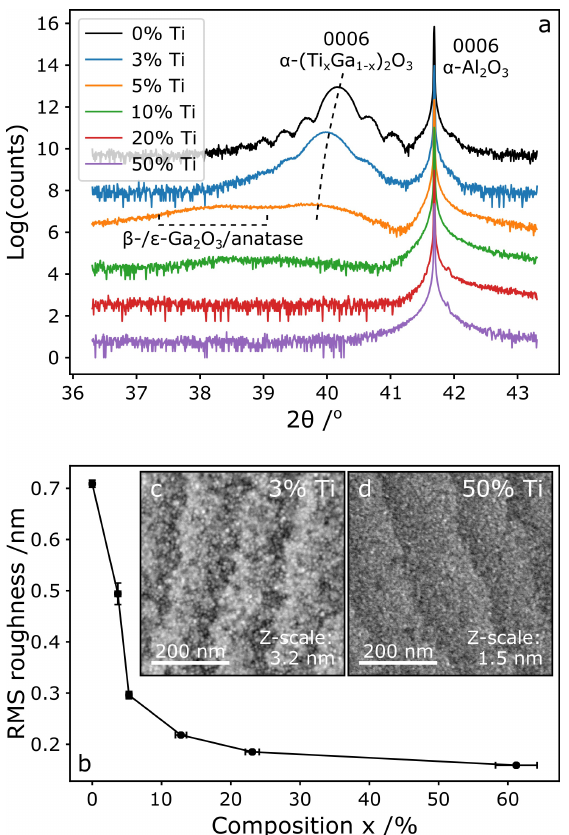
Figure 2. ( a ) 2 θ - ω XRD scans of the symmetric 0006 reflection of the α phase. ( b ) Variation of RMS surface roughness with Ti concentration. ( c , d ) 500nm size AFM images of the 3%Ti ( c ) and 50%Ti ( d )